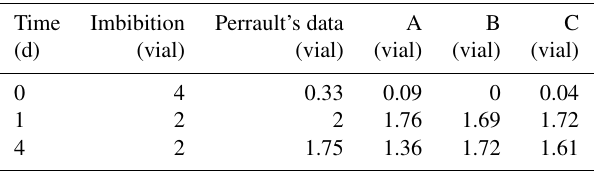
Table 6. Imbibition and percolation volumes measured during the third experiment. Data are reported as the number of vials, in order to make a comparison with Perrault’s data. The unitary volume V i of a vial was estimated to be equal to V i = 31.3, 50.5 and 41.0cm 3 for soil A, B and C, respectively, according to the procedure described in Sect.